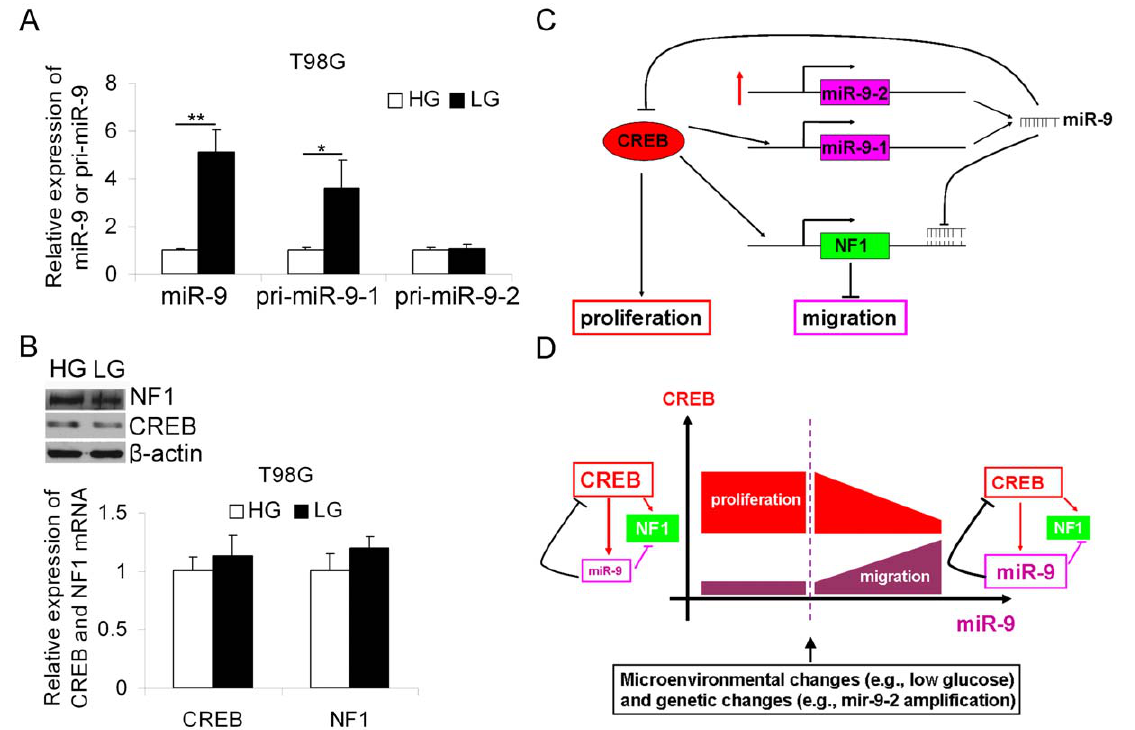
Figure 7. A low concentration of glucose induces the expression of miR-9. (A and B) T98G cells were maintained in DMEM/high glucose (4.5 g/L, HG) or DMEM/low glucose (1.0 g/L, LG) DMEM for 24 h. Cells were then harvested for RNA and protein extraction. The mRNA expression levels of miR-9, pri-miR-9-1, pri-miR-9-2, CREB and NF1 were determined by quantitative RT-PCR (mean 6 SD, n=3), and the protein levels of CREB and NF1 were detected by western blotting. (C) The negative feedback minicircuitry comprised of miR-9 and CREB. MiR-9 is highly expressed in glioma cells with amplification of the miR-9-2 gene copy number. The up arrow denotes genomic amplification. The transcription of miR-9-1 is regulated by CREB and miR-9 can directly target the 3 9 UTR of CREB, forming negative feedback minicircuitry. CREB inhibits the migration of glioma cells by elevating the expression level of NF1, whereas miR-9 promotes migration by directly targeting NF1 and CREB. In addition, miR-9 inhibits the proliferation of glioma cells by directly targeting the proliferation-promoting transcription factor, CREB. (D) The balance between miR-9 and CREB coordinates the migration and proliferation of glioma cells. The glioma cells with low levels of miR-9 and high CREB protein levels prefer to proliferate rather than migrate. As the glioma progresses, certain events, such as glucose reduction and mir-9-2 gene copy number amplification trigger the substantial increase of miR-9. By targeting migration-inhibitory CREB and NF1, miR-9 promotes the migration of glioma cells accompanied by proliferation